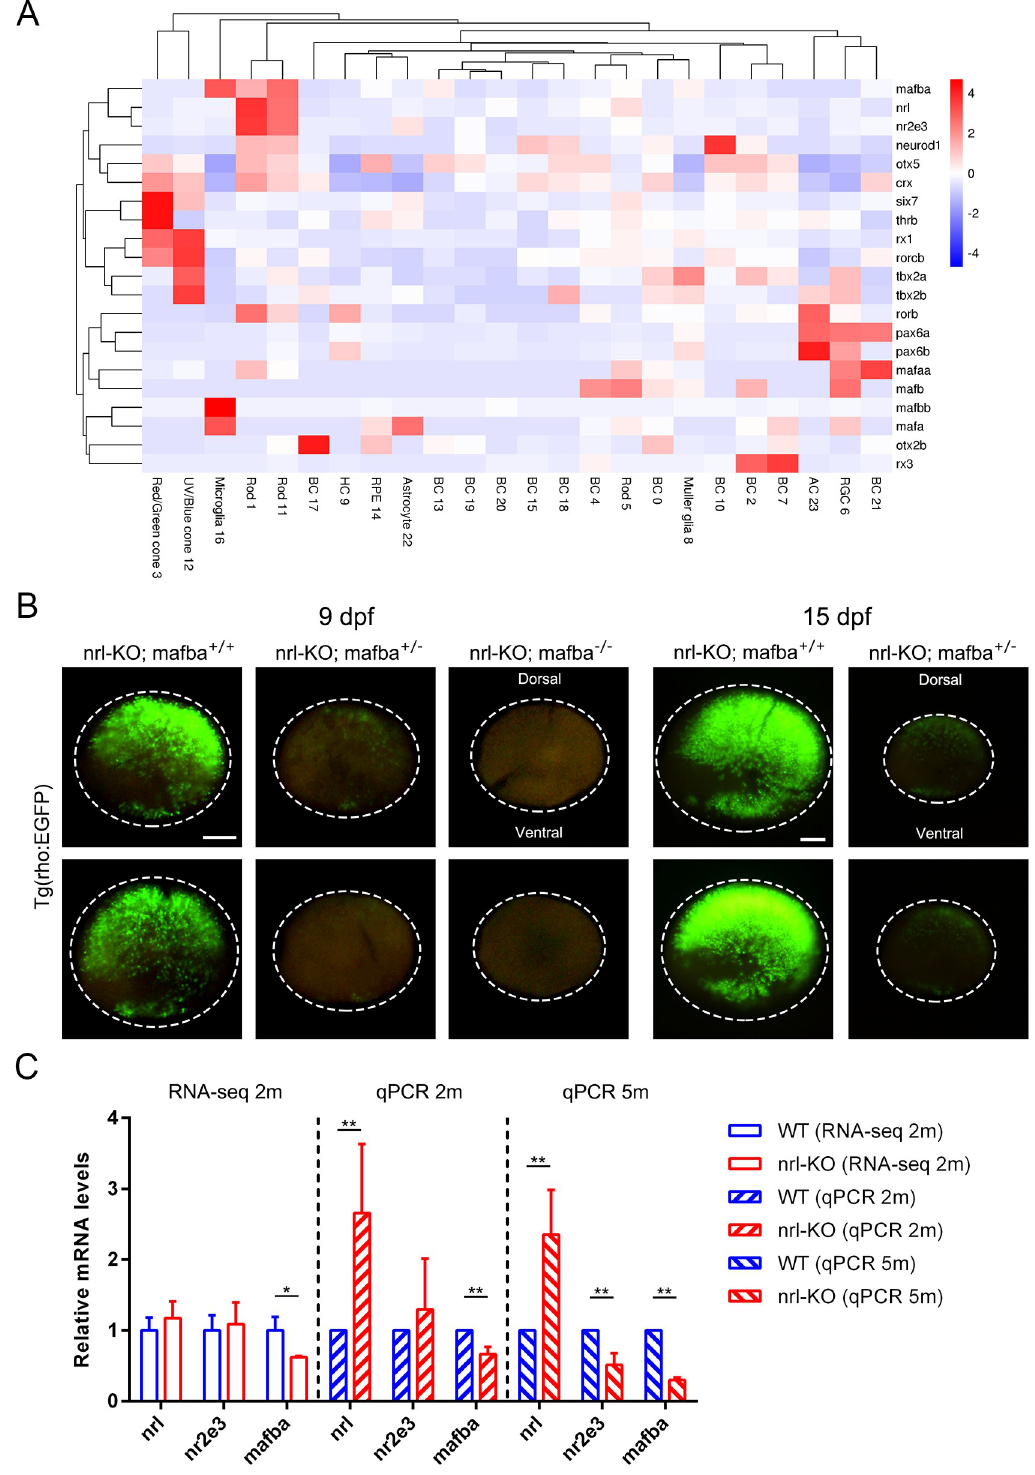
Fig 8. Identification of the mafba gene as a novel driving factor for the development of nrl -independent rods. (A) Clustering analysis of the large MAF genes and the genes involved in photoreceptor development by using the expression data from scRNA-seq. The cell-type-specific expression pattern of mafba was highly similar to those of nrl and nr2e3 . (B) The distribution of rods (labeled with EGFP) in the nrl -KO zebrafish carrying the WT, heterozygous, and homozygous mafba alleles